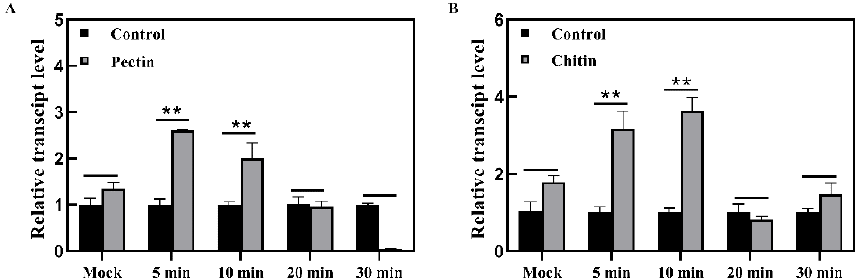
Figure 8. Transcript profiles of TaWAK7D responding to exogenous pectin and chitin treatments. ( A ) Transcript profiles of TaWAK7D in wheat cv. CI12633 leaves treated by 100 μg /mL exogenous pectin. ( B ) Transcript profiles of TaWAK7D in leaves of wheat cv. CI12633 after exogenous application of 100 μg /mL chitin. The transcript level of TaWAK7D in mock-treated wheat plants is set to 1. Statistically significant differences are analyzed based on three biological replications (Student’s t -test: ** p < 0.01). Error bars indicate the